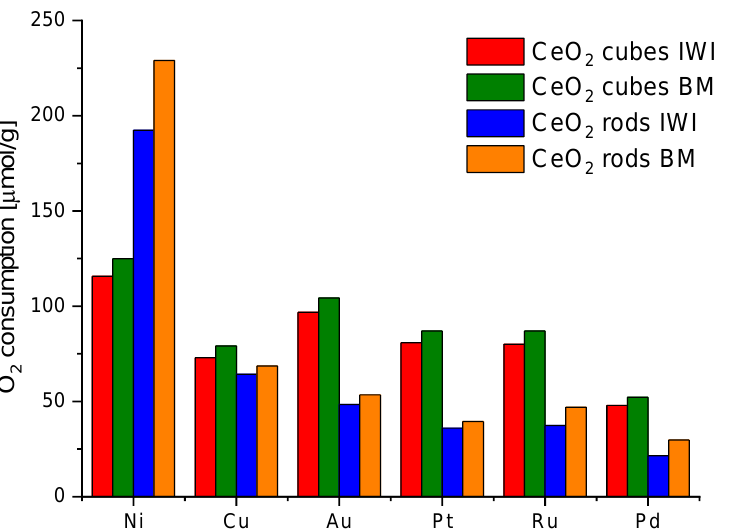
Figure 8. Oxygen consumption from CO 2 pulse chemisorption of CeO 2 cubes and CeO 2 rods deco- rated with different metals and prepared by different methods.